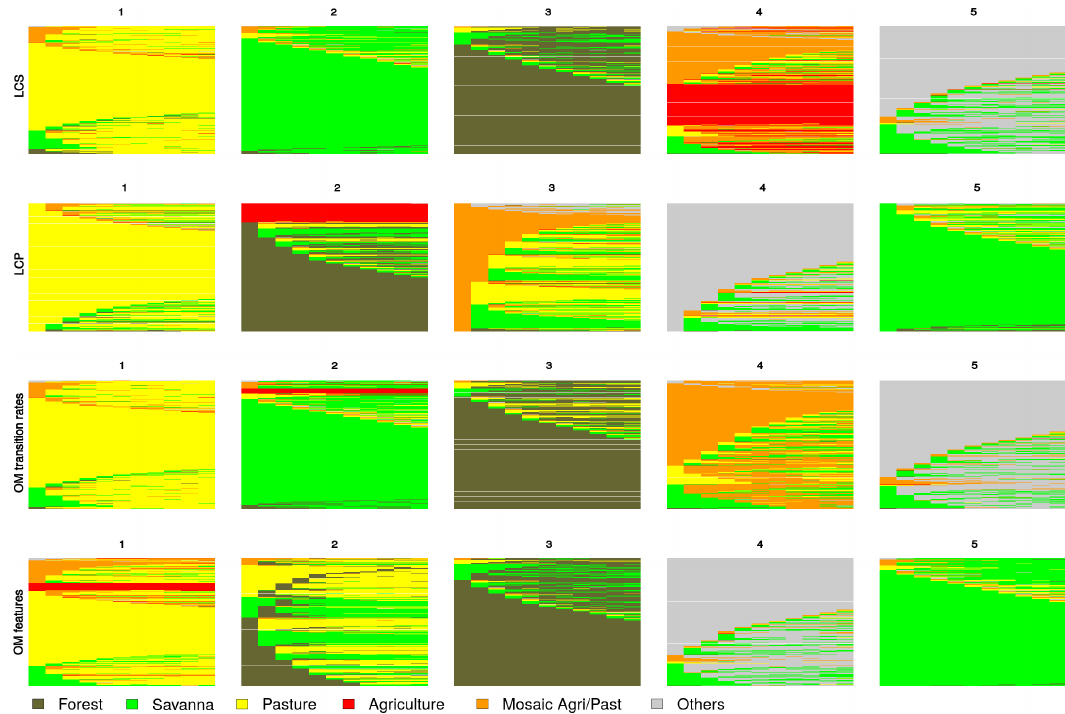
Figure 8. Sequences belonging to the different clusters using the four dissimilarity